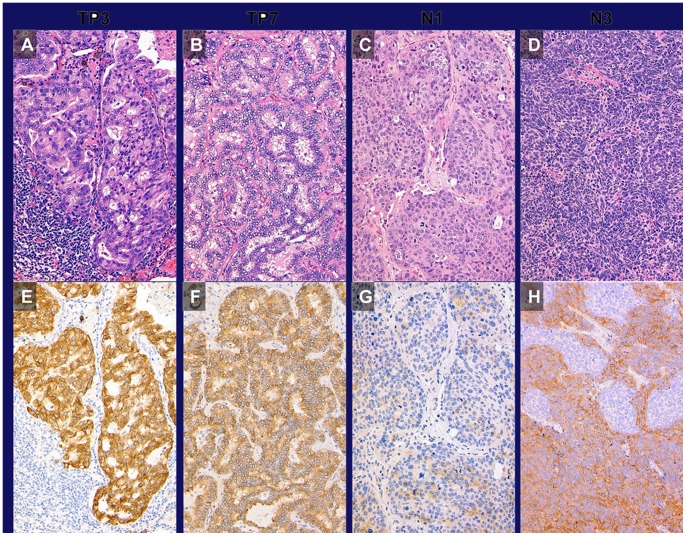
Histological features of ALK-positive and ALK-negative adenocarcinomas on H&E stain (A, B, C, D) and on ALK immunostaining by the iAEP method (E, F, G, H).P3 and P7 (A and B, respectively), adenocarcinomas with mucinous cribriform pattern, showed iScore 3 (E and F, respectively); N1 (C), squamous cell carcinoma showed iScore 1 (G); N3 (D), small cell carcinoma showed iScore 2 (H).